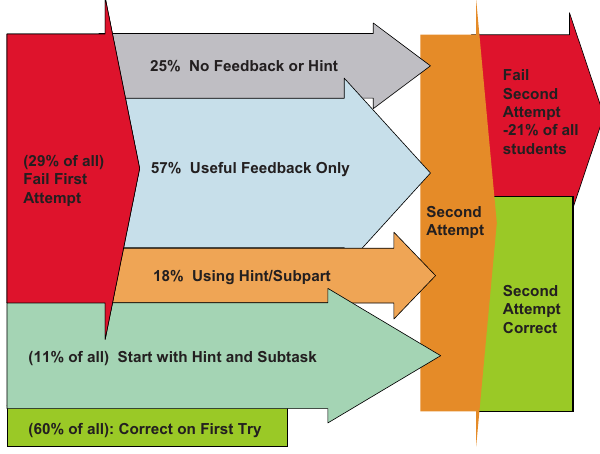
FIG. 2. (cid:1) Color (cid:2) Transition diagram showing several possible paths involving the first